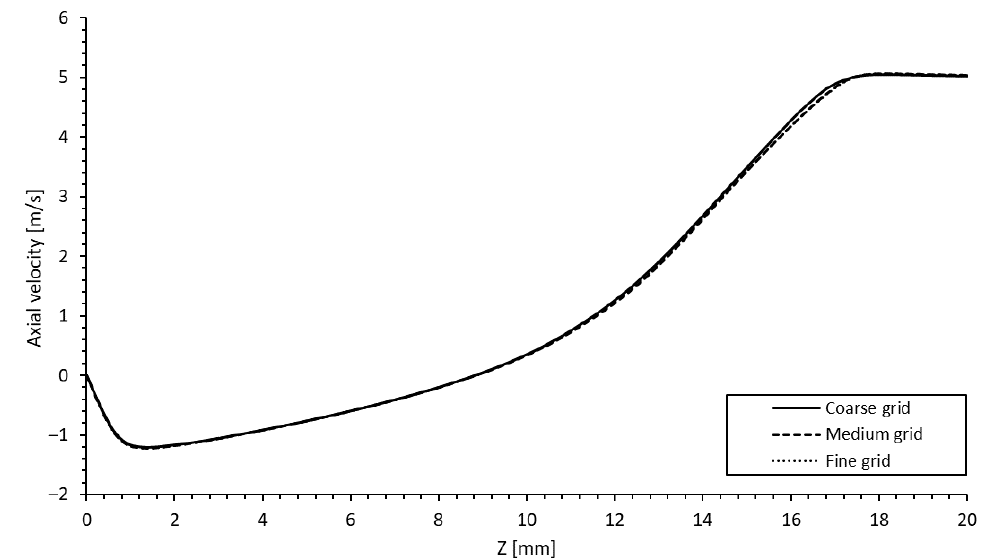
Figure 8. Simulated axial velocity for the three grids at S4. The ordinate is clipped at Z =